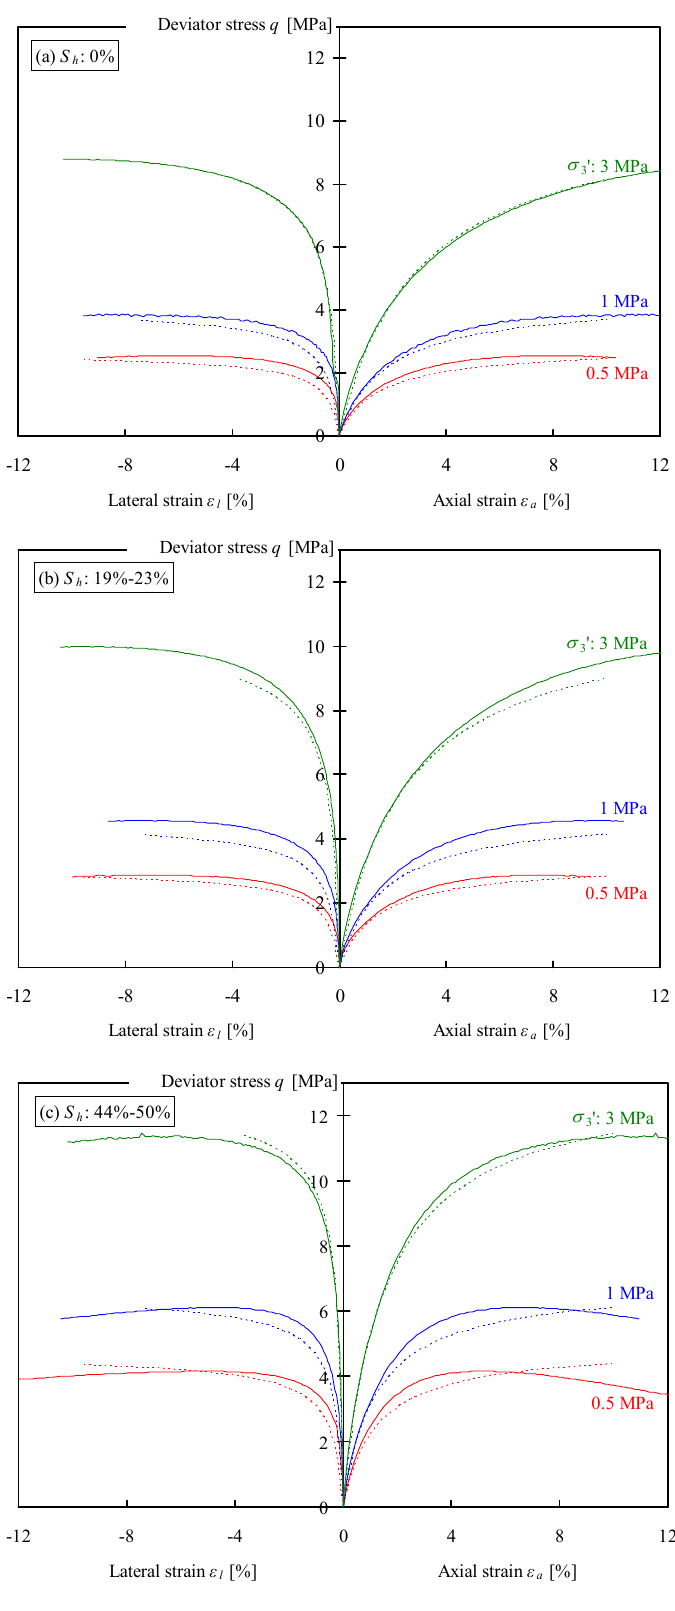
Figure 5. Experimental (solid lines) and calculated (broken lines) deviator stress q versus axial strain ε and lateral strain ε for specimens formed by No. 8 silica sand with methane a l hydrate saturation S of ( a ) 0%; ( b ) 19%–23% and ( c ) 44%–50%. Experimental results are h taken from the reference